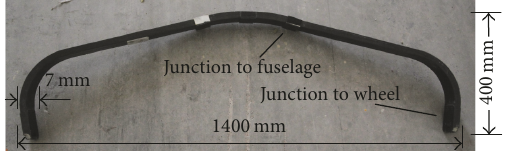
Figure 2: The composite landing